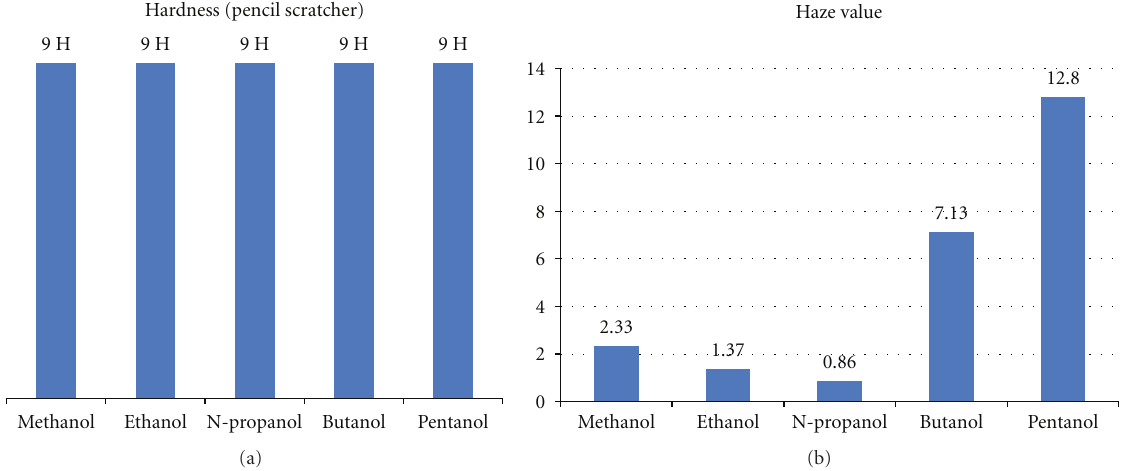
Figure 2: (a) The scratch hardness values based on the Mitsubishi pencil scratcher and (b) the haze values of thee coated samples.